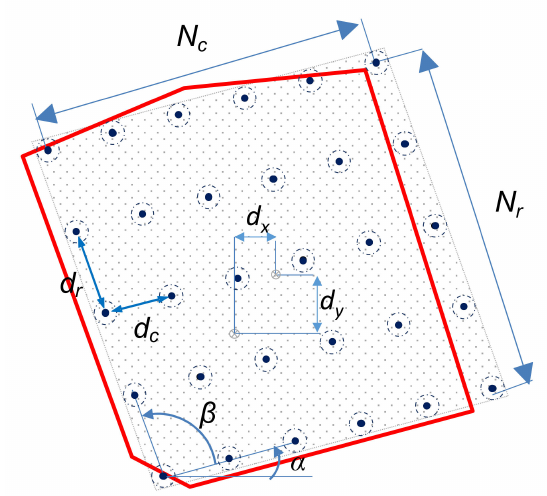
Figure 4. Variables employed to define the FOWF layout. The red lines stand for the limits of the available plot (plot feasible surface) and the dotted surface represents the area occupied by the wind